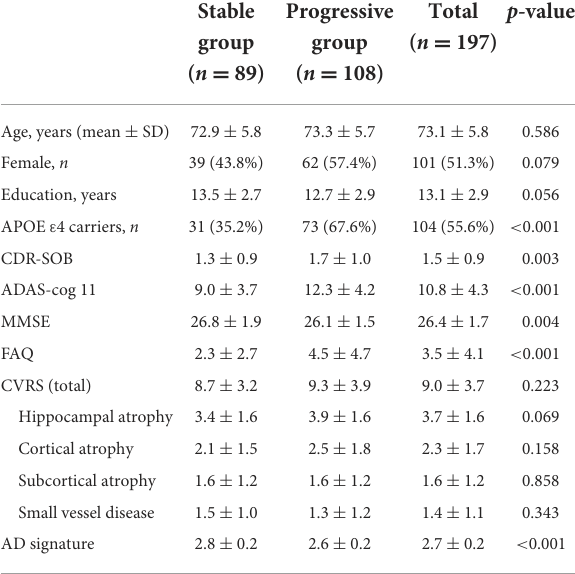
TABLE 2 Baseline characteristics of the patients with